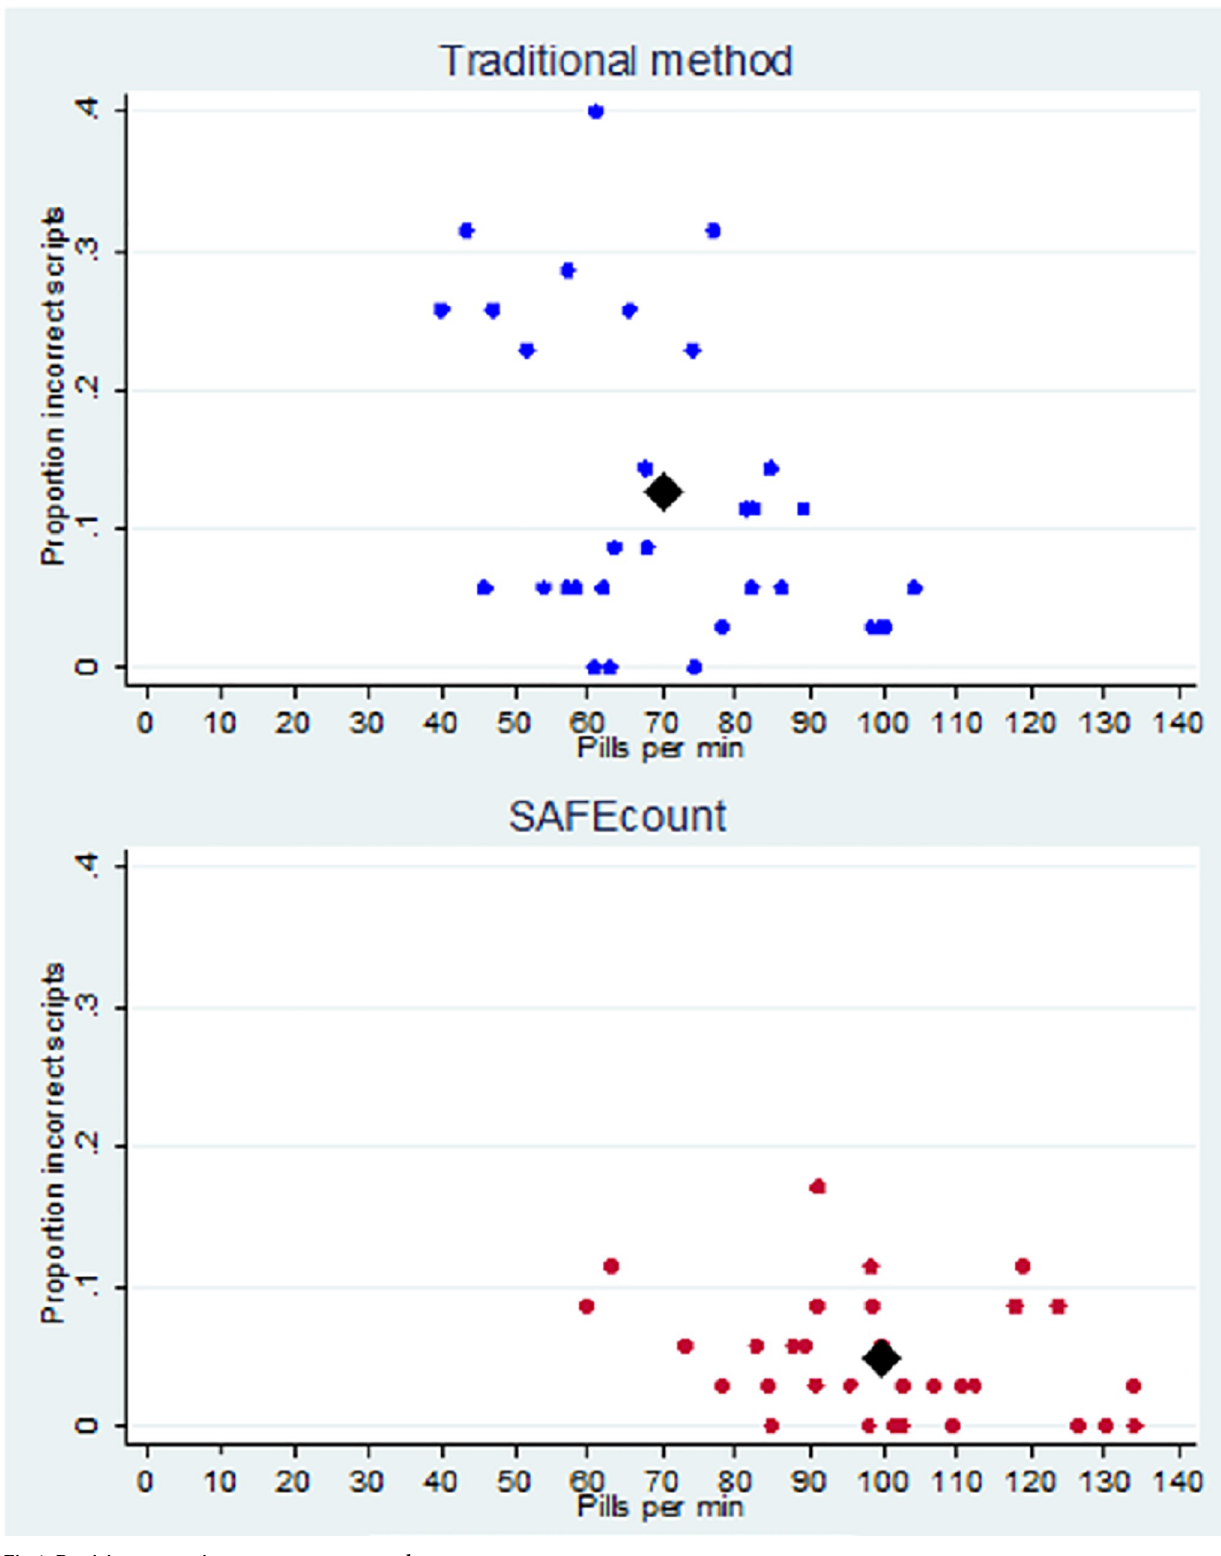
Fig 4. Participant counting accuracy versus speed.